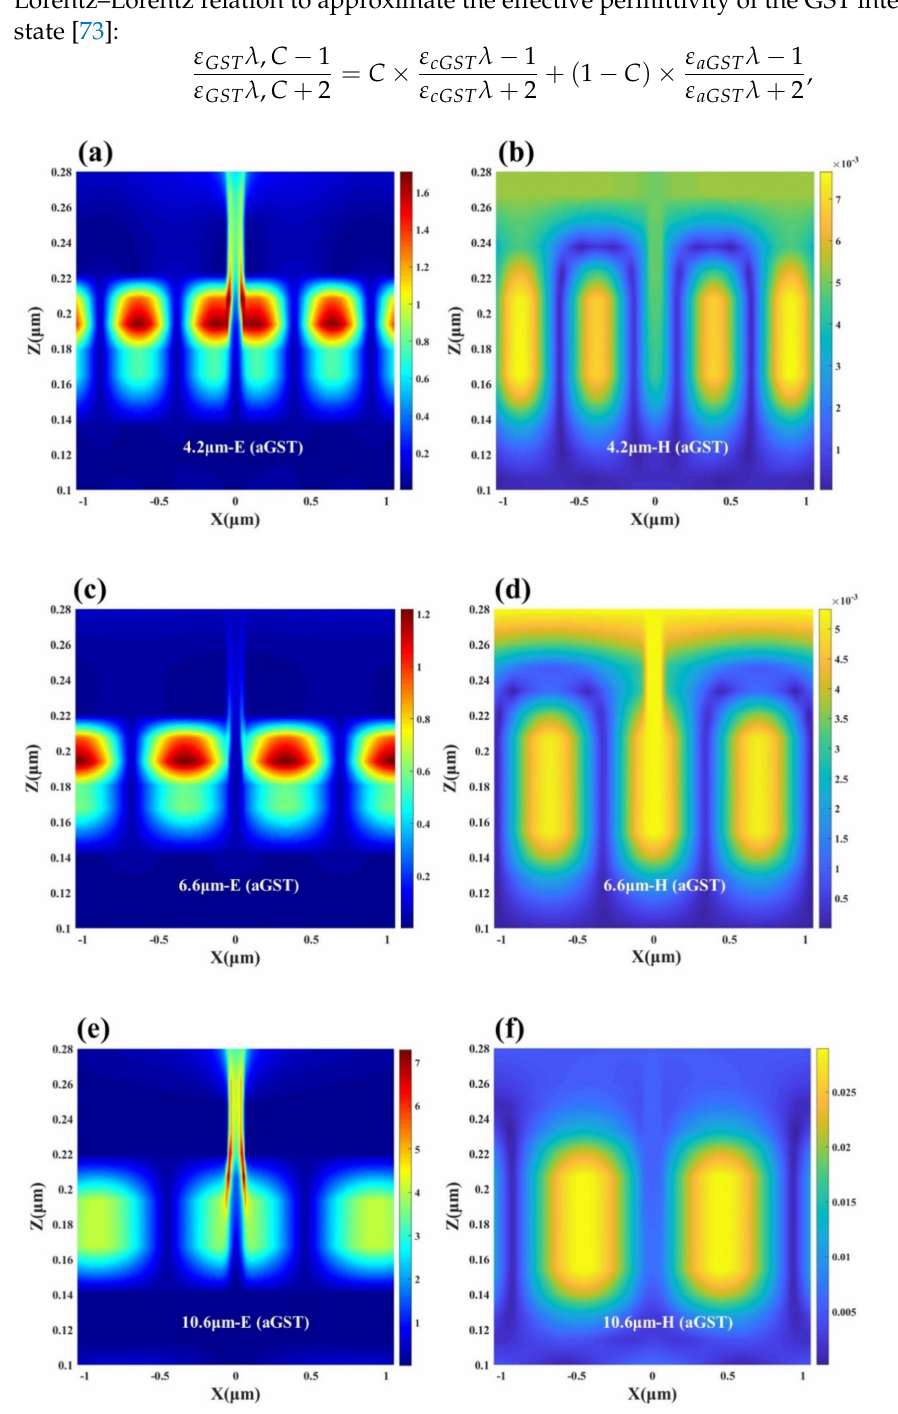
Figure 6. Schematic diagram of the electric and magnetic field distributions of the designed five-layer structure containing aGST thin films ( a , b ) at the first absorption peak, ( c , d ) at the second absorption peak and ( e , f ) at the third absorption